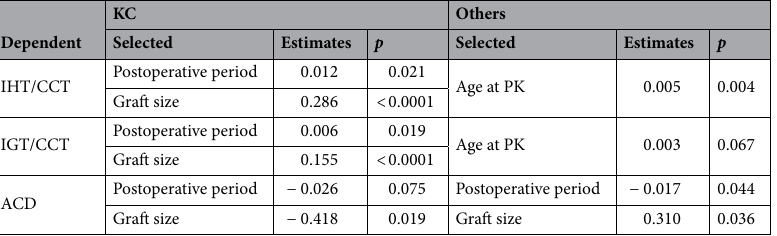
Table 3. Factors associated with corneal ectasia indicators in KC and others: multivariant regression analysis of IHT/CCT, IGT/CCT, and ACD as the dependent variables with the independent variables of age at PK, current age, postoperative period, sex, and graft size. KC keratoconus, IHT inferior thinnest host cornea thickness, CCT central corneal thickness, IGT inferior thinnest graft thickness, IHT/CCT IHT ratio to